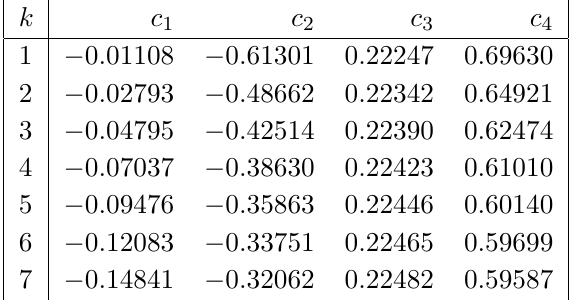
Table 1 . The numerical (cid:12)t for the coe(cid:14)cients of f N 2 = 3 ; N 1 = 3 ; log N; 1 g in the saddle point evalu- ation of the free energy. The (cid:12)t is performed independently for each (cid:12)xed value of k with N from 100 to